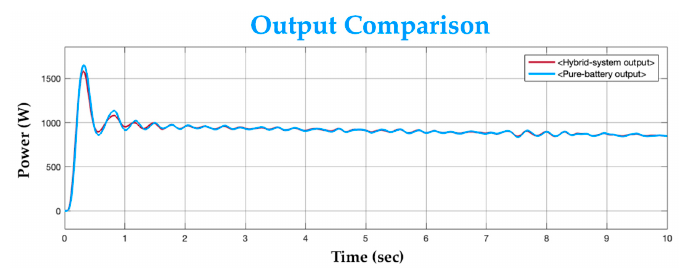
Figure 16. Output comparison graph.